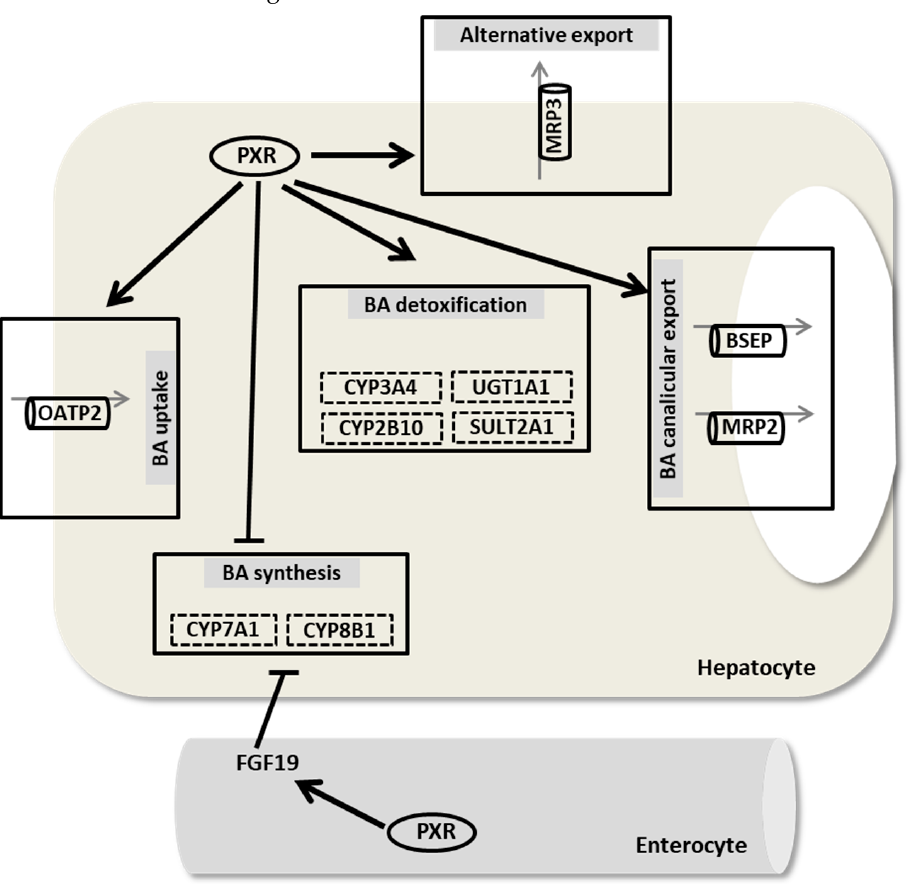
Figure 2. The role of PXR in bile acid metabolism in humans. PXR represses BA synthesis by inhibiting the expression of CYP7A1 and CYP8B1. Intestinal PXR activates FGF19, which in turn inhibits BA synthesis. PXR induces BA detoxification (CYP3A4, CYP2B10, and SULT2A1) and stimulates bilirubin conjugation (UGT1A1) and excretion (MRP2, BSEP, and MRP3). Additionally, PXR can induce BA uptake via OATP2. PXR, pregnane X receptor; OATP, organic anion transporting polypeptide; BSEP, bile salt export pump; MRP, multidrug resistance protein; FGF, fibroblast growth factor; CYP7A1, cholesterol 7 α -hydroxylase; CYP8B1, sterol 12- α -hydroxylase; CYP3A4, cytochrome P450 3A4, CYP2B10, cytochrome P450 2B10; UGT1A1, uridine diphosphate glucuronosyltransferase; and SULT2A1, sulfotransferase 2A1. Bold black arrows indicate induction; bars indicate inhibition; ellipses denote receptors; cylinders denote transporters; and broken line boxes denote